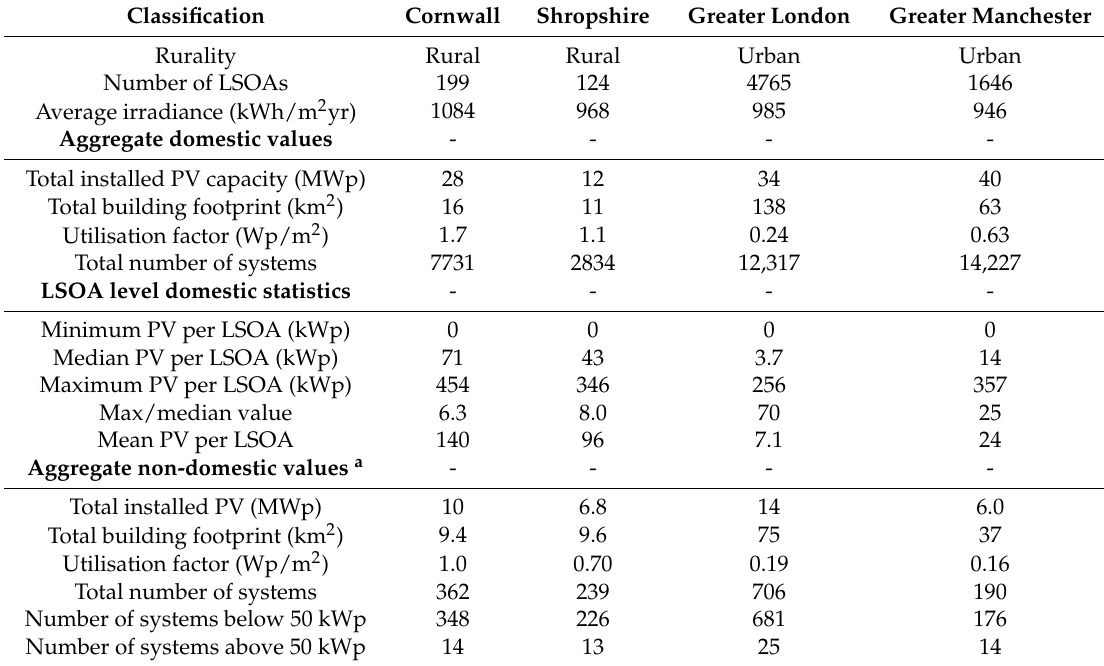
Table 4. Key features of domestic and non-domestic PV deployment in the case studies. Classification Cornwall Shropshire Greater London Greater Manchester Rurality Rural Rural Urban Urban